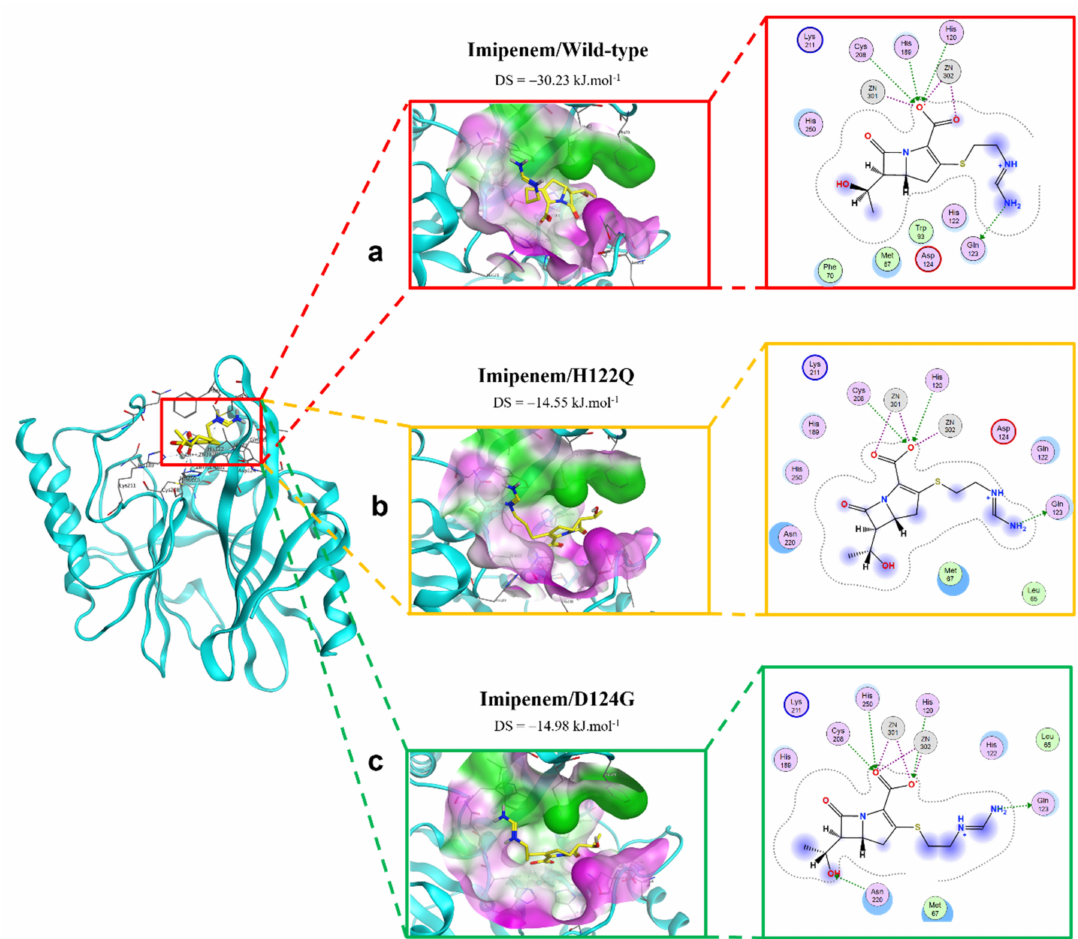
Figure 4. The binding site of imipenem with NDM-1 wild-type and mutant proteins. ( a ) Wild type. ( b ) H122Q. ( c )